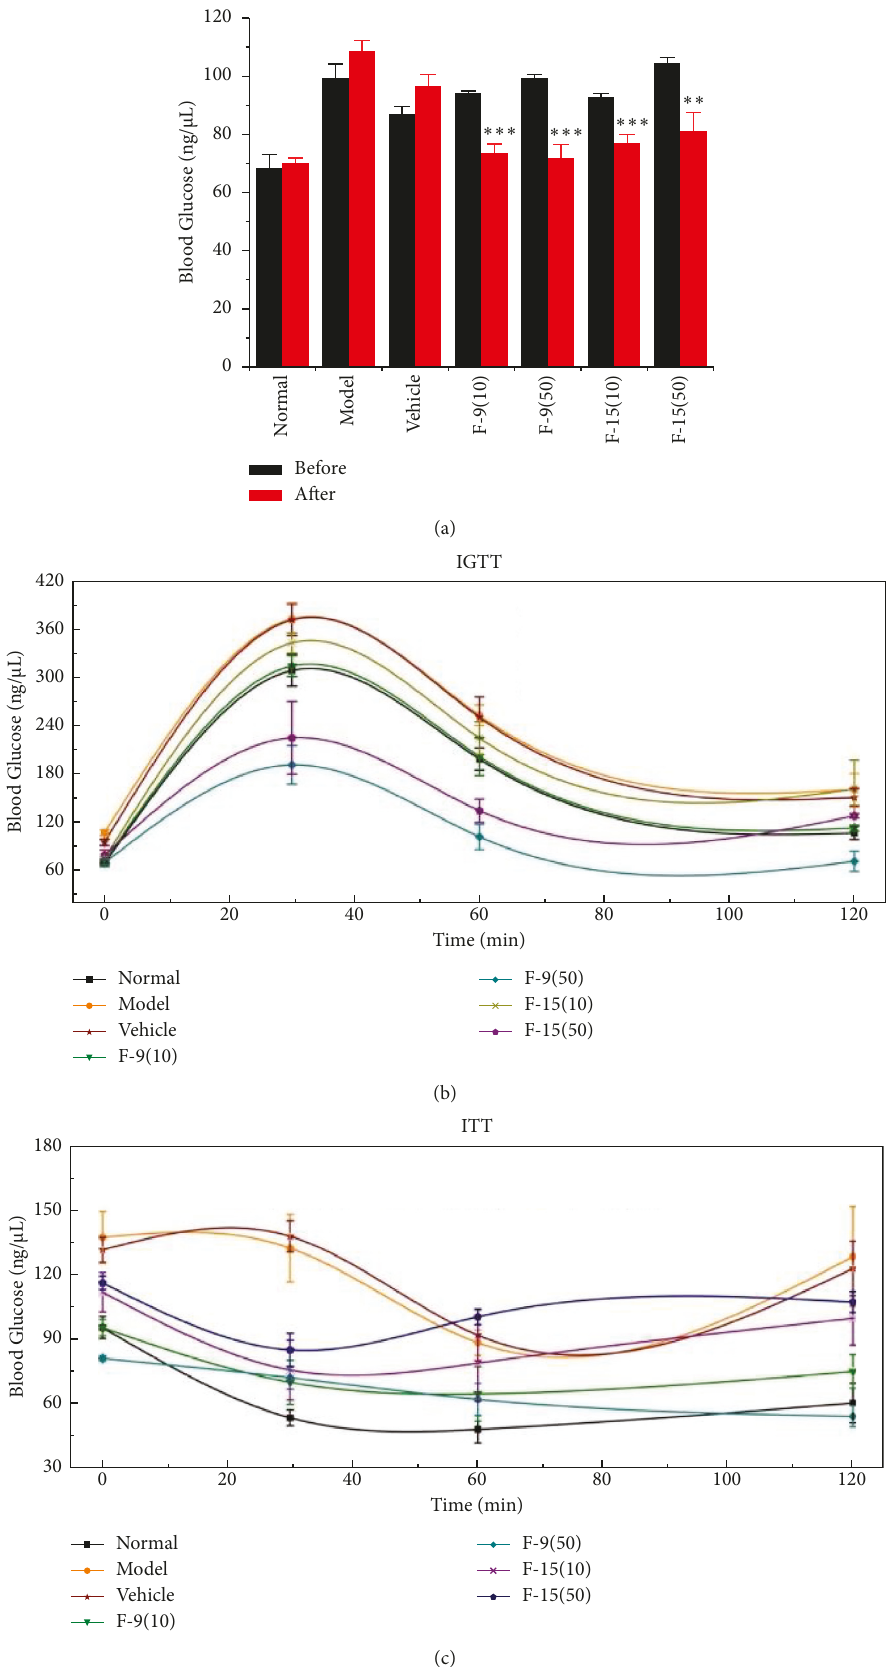
Figure 3: Fasting blood glucose, intraperitoneal injection glucose tolerance (IGTT), and insulin tolerance (ITT) were measured ( 0 .